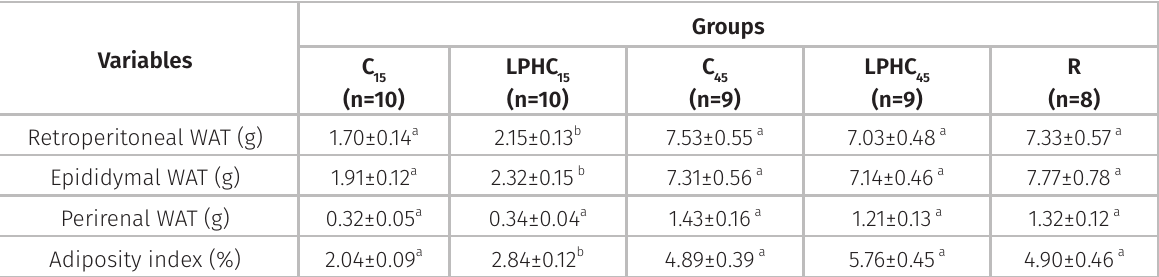
, LPHC , C , LPHC , and R groups. 15 15 45 45 Groups